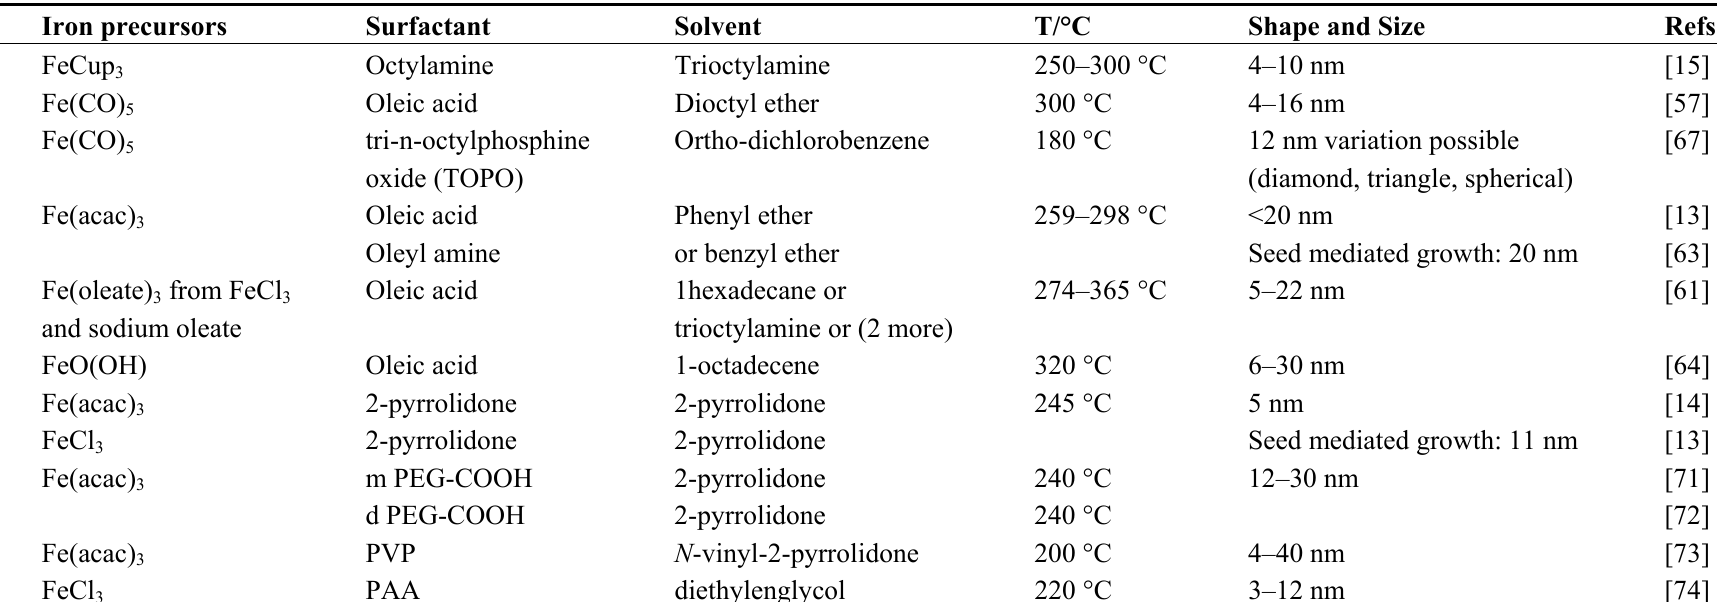
Table 1. Main aspects of the synthesis of superparamagnetic iron oxide nanoparticles by thermal decomposition methods. PAA, polyacrylic